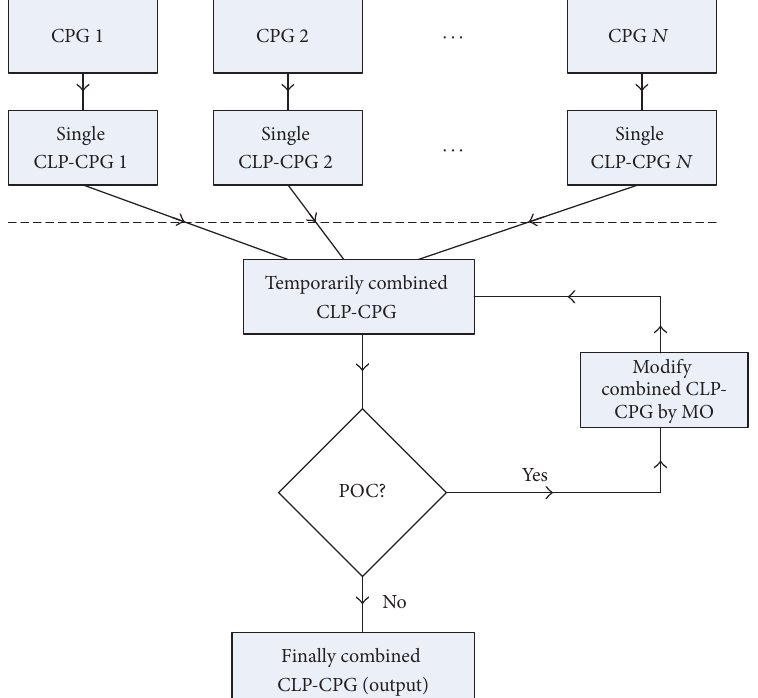
Figure 5: Flow chart of a CPG-CLP model given 𝑁 CPGs to combine (CLP = constant logic programming, CPG = clinical practice guideline, POC = point of contention, and MO = mitigation